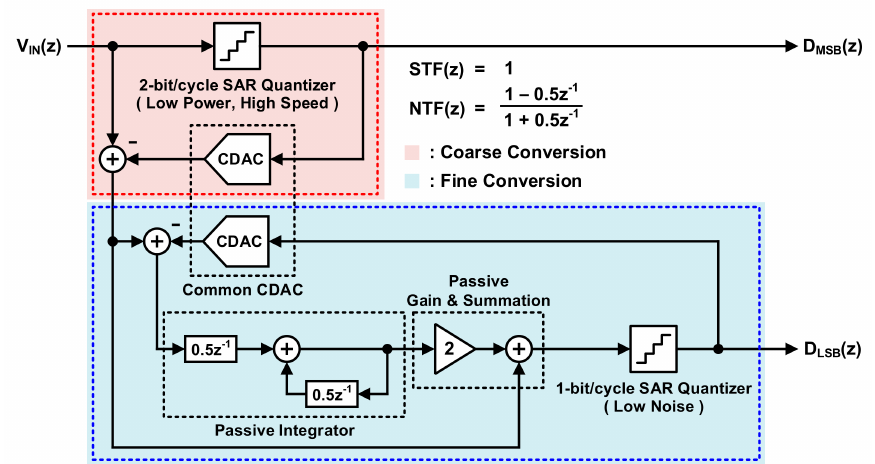
Figure 2. Block diagram of proposed 2-then-1-bit/cycle noise-shaping SAR